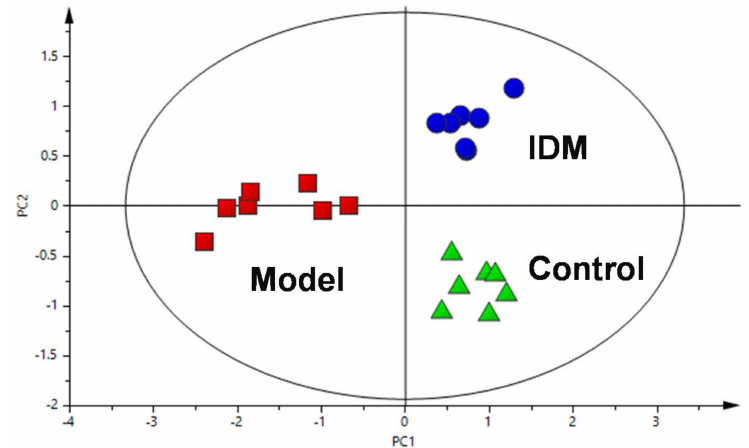
Figure 4. PLS-DA scores plot of rat serum data in control group (green triangles, n = 7), model group (red squares, n = 7), and IDM group (blue dots, n =